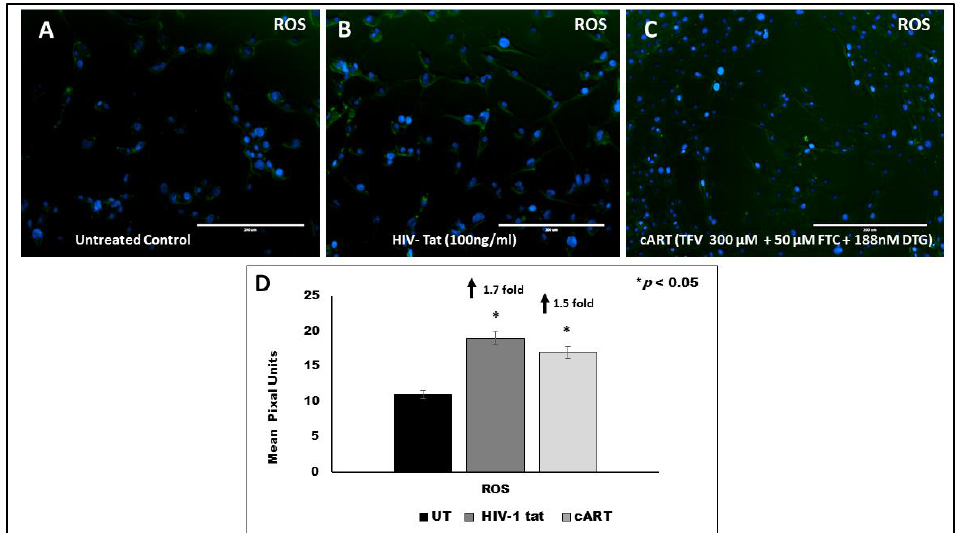
Figure 6. Effect of HIV tat and cART on ROS production in HTHU microglial cells was quantitated by measuring the green fluorescence product resulting from oxidation of CM-H2DCFDA. Panel ( A ): Untreated control; Panel ( B ): HIV tat (100 ng/mL) treated microglia cells; Panel ( C ): cART (300 µ M TFV + 50 µ M FTC + 188 nM DTG) treated microglia cells; Panel ( D ): Representative histogram of